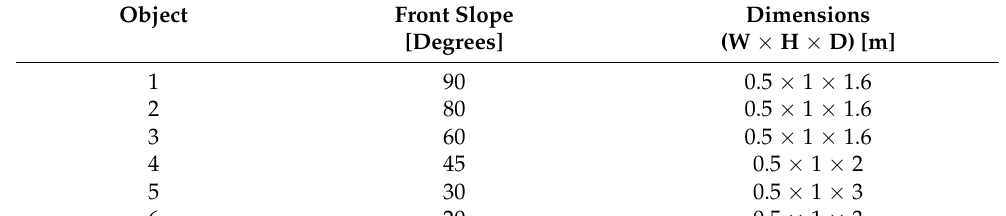
Table 1. Four objects used in the simulation.